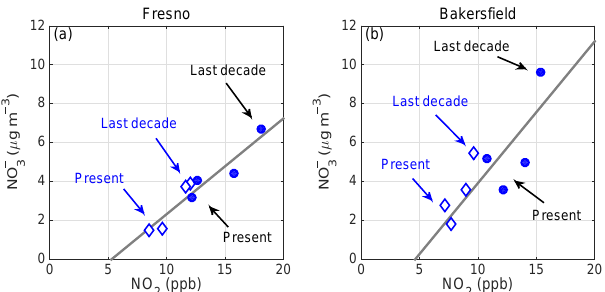
Figure 2. Observed NO − (µgm − 3 ) in PM 10 versus daytime 3 (10:00–15:00LT) NO 2 on weekdays (closed circles) and week- ends (open diamonds). Data are 3-year medians of wintertime (November–March) data in Fresno (a) (2001–2012) and Bakers- field (b) (2001–2013). There are an average of 41 weekday days and 18 weekend days point − 1 . Uncertainties in NO − are ± 32 %µgm − 3 3 20 on weekdays and ± 40 %µgm − 3 on weekends for NO − and less 30 3 than ± 9% on weekdays and ± 13% on weekends for NO 2 (see text for details). Slopes are 0.5µgm − 3 NO − ppb − 1 NO 2 in Fresno and 3 0.64µgm − 3 NO − ppb − 1 NO 2 in Bakersfield and are calculated us- 3 ing a weighted linear least squares fit with errors assumed in both the x and y ; weights are computed as counting errors derived from the number of